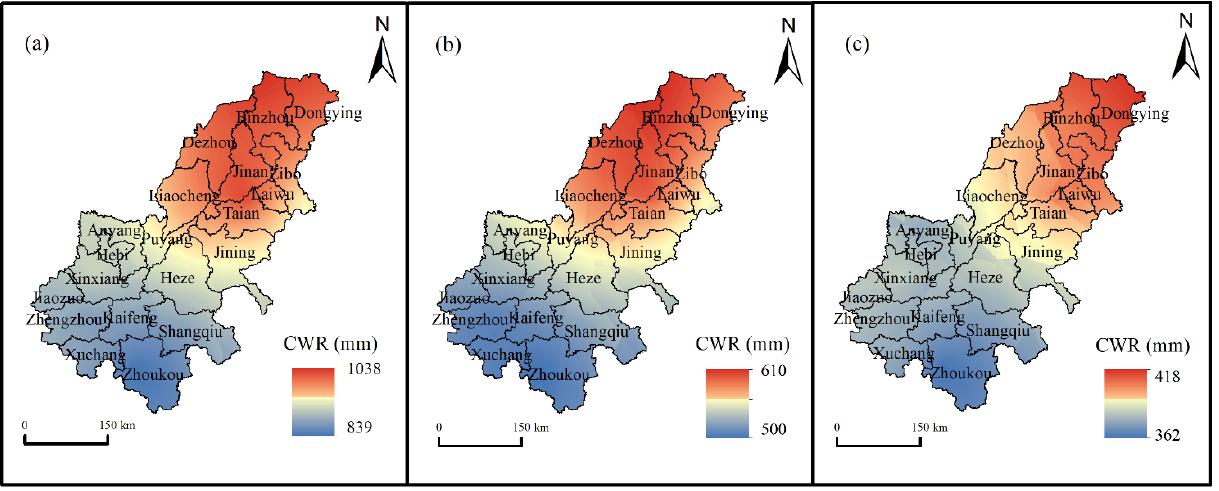
Figure 3. Spatial distribution of multi-year average crop water requirement of winter wheat and summer maize from 1981 to 2019 in the lower reaches of the Yellow River Basin. ( a - c ) Toal water requirement, winter wheat, and summer maize, respectively.